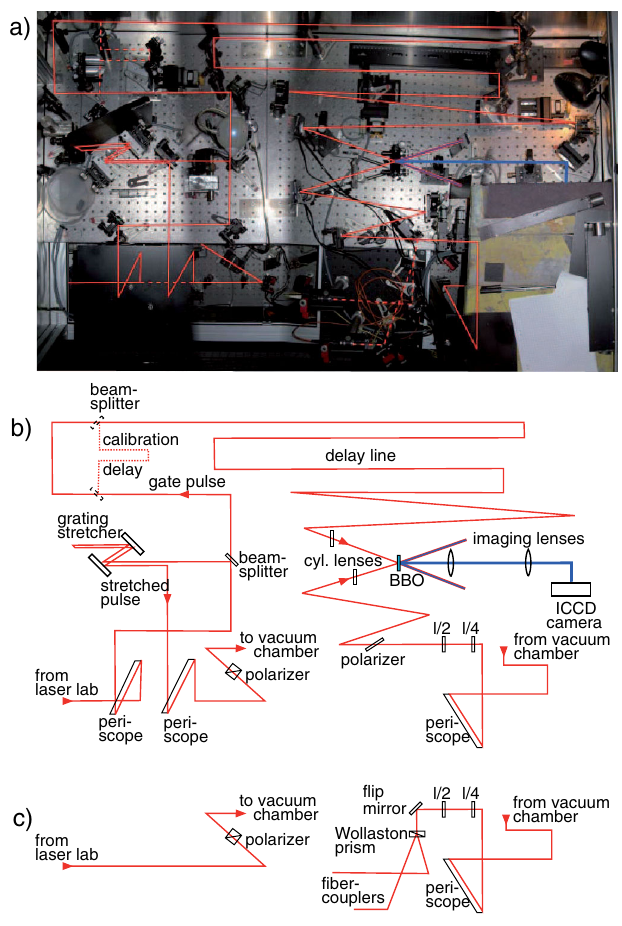
FIG. 8. (Color) (a) Photograph of the electro-optic setup in the accelerator tunnel with the laser beam path. (b) Laser beam path for electro-optic temporal decoding (EOTD). The beam splitters of the calibration delay line can be removed once the time calibration has been done. (c) Laser beam path for the electro- optic spectral decoding